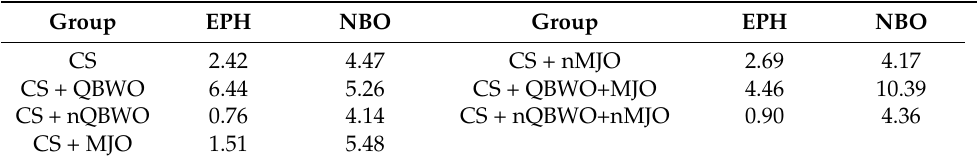
Table 1. Composite rainfall anomalies (unit: mm) area − averaged over the EPH (10 ◦ –20 ◦